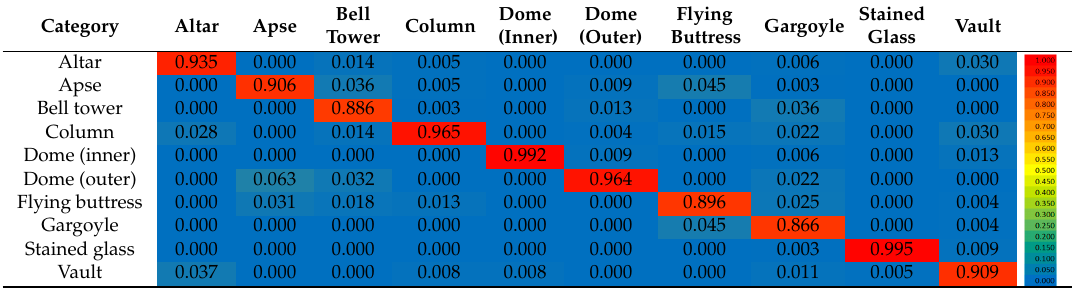
Table 8. Different metrics of the results obtained in each class using a ResNet network (full-training) and the validation dataset. Altar